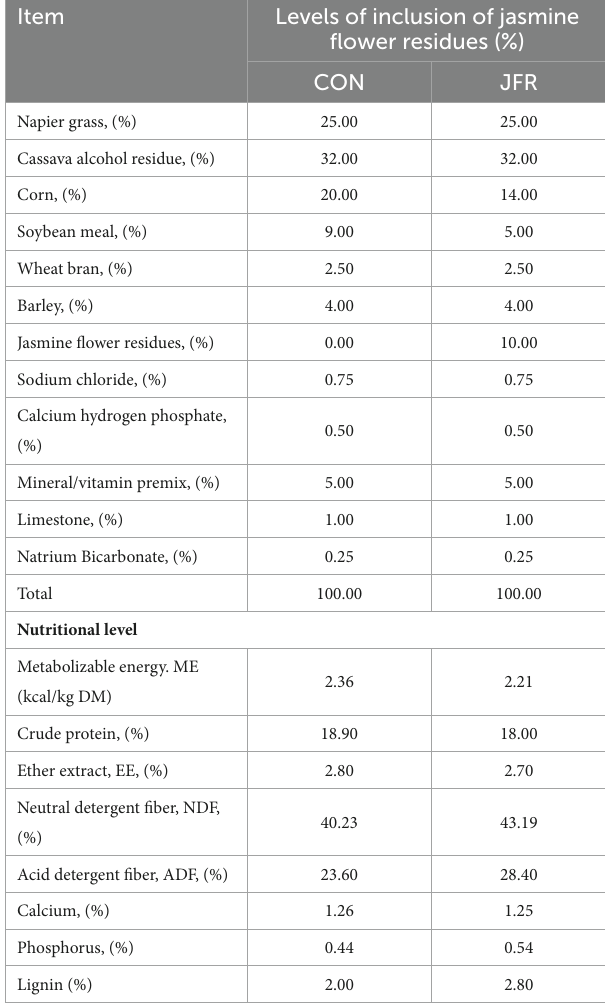
TABLE 1 Composition and nutrient levels of diets (air-dry matter